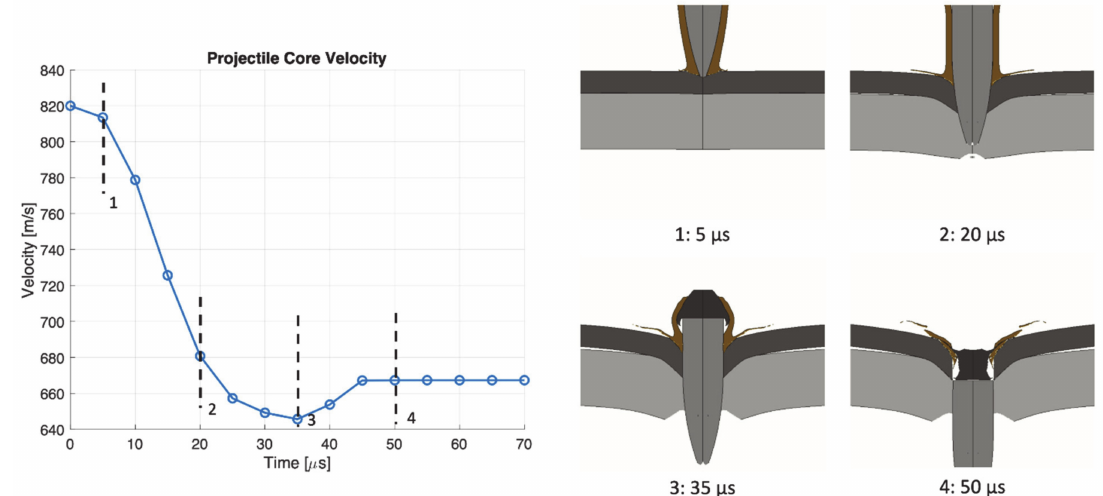
Figure 15. Perforation process in target SA at 820 m/s impact velocity.